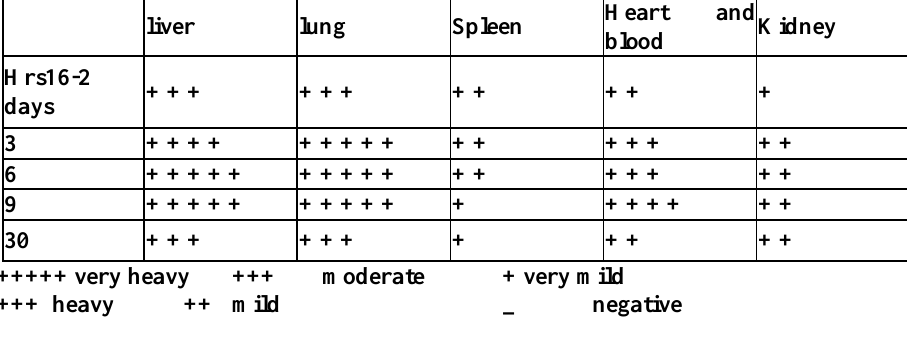
Table (2): bacterial isolation from rabbit’s organs of the 2 nd